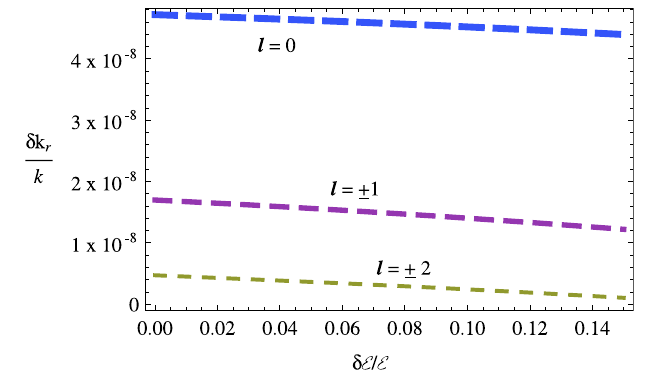
FIG. 2. (Color) Effective guiding due to the linear FEL interac- tion for OAM modes at resonance. Higher-order modes have a reduced coupling and are guided less strongly, and thus have a larger axial phase velocity through the e-beam. FEL model parameters are identical to Fig.